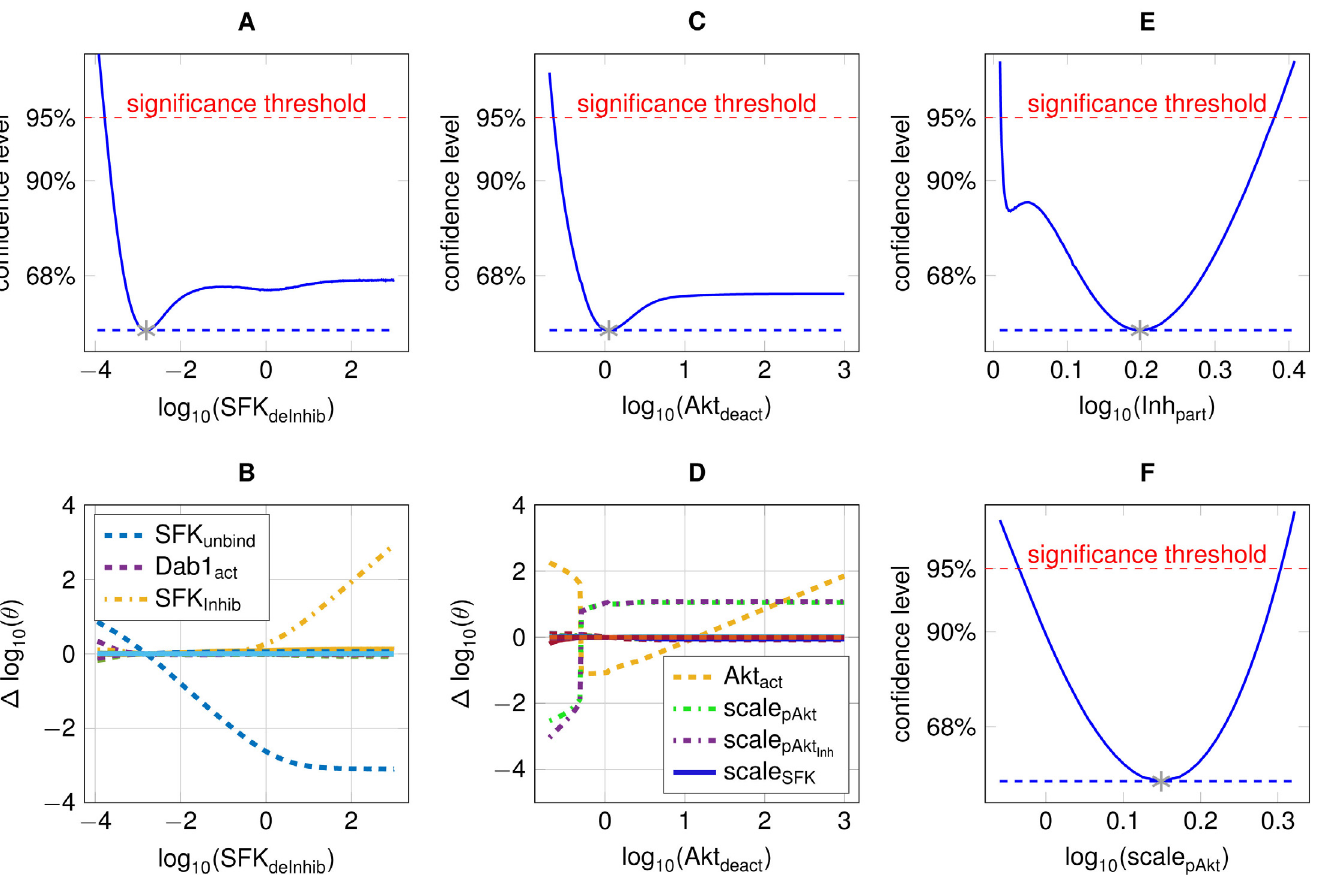
Fig 8. Summary of model reduction steps. A : The profile likelihood of the inhibitor release from SFKs. B : The re-optimised paths of the remaining parameters with respect to the profile of the inhibitor release. C : Parameter profile likelihood of the Akt deactivation. D : Coupling of the Akt activation, log ( Akt act ), to the Akt deactivation shown in panel C. E : Identifiable partitioning of SFKs with and without bound inhibitor. F : The scaling factor scale pAkt , which links the observations of pAkt to pDab1, is identifiable.